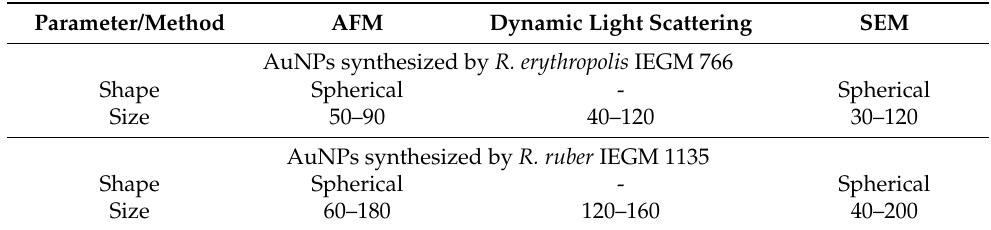
Table 2. Comparative summary of shape and size (nm) of biosynthesized AuNPs as measured by different